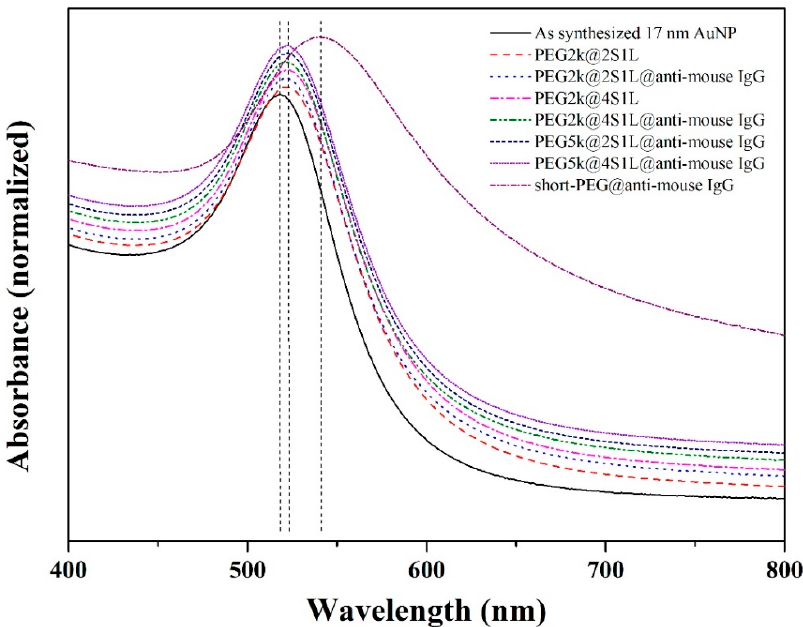
Figure 2. UV-Vis spectra of as synthesized AuNPs (17 nm) and AuNPs bioconjugated with an anti-mouse IgG via various poly(ethylene glycol) linkers. Table 1. Hydrodynamic diameters of as synthesized AuNPs (17 nm), and PEGylated and anti-mouse IgG bioconjugated AuNPs by dynamic light scattering.